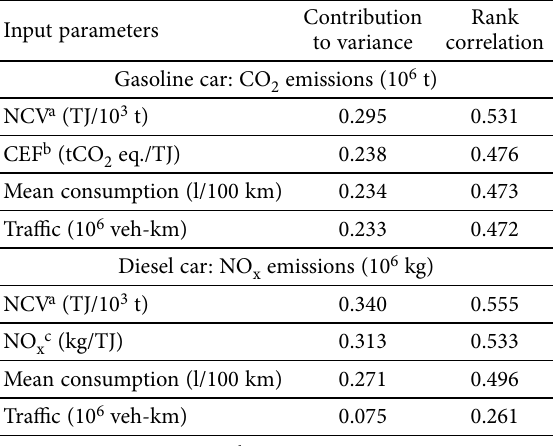
Table 5. Sensitivity analysis for Spanish interurban road transport emissions upon parameter